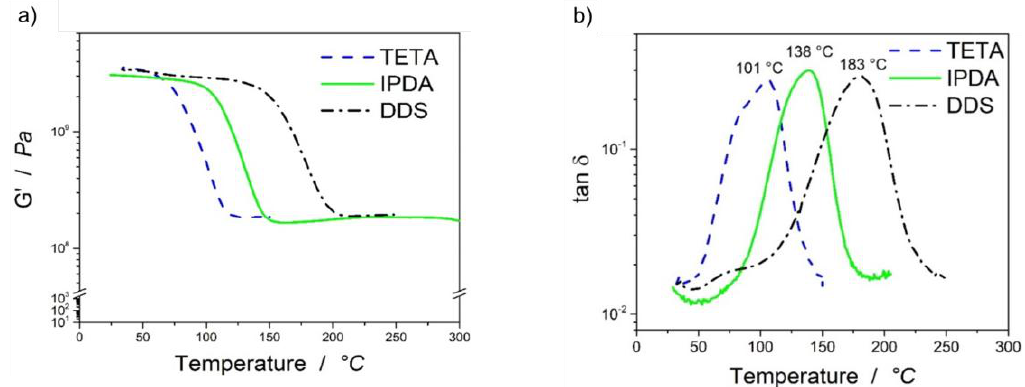
Figure 3. ( a ) Storage modulus ( G I ) and ( b ) tan( δ ) of the resin transfer molding (RTM) laminates cured with various hardeners.